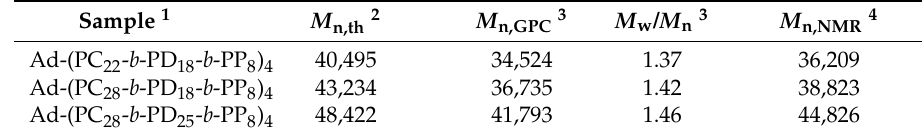
Table 1. Synthesis Results of Copolymers Ad-(PCL-b-PDEAEMA-b-PPEGMA) 4 .